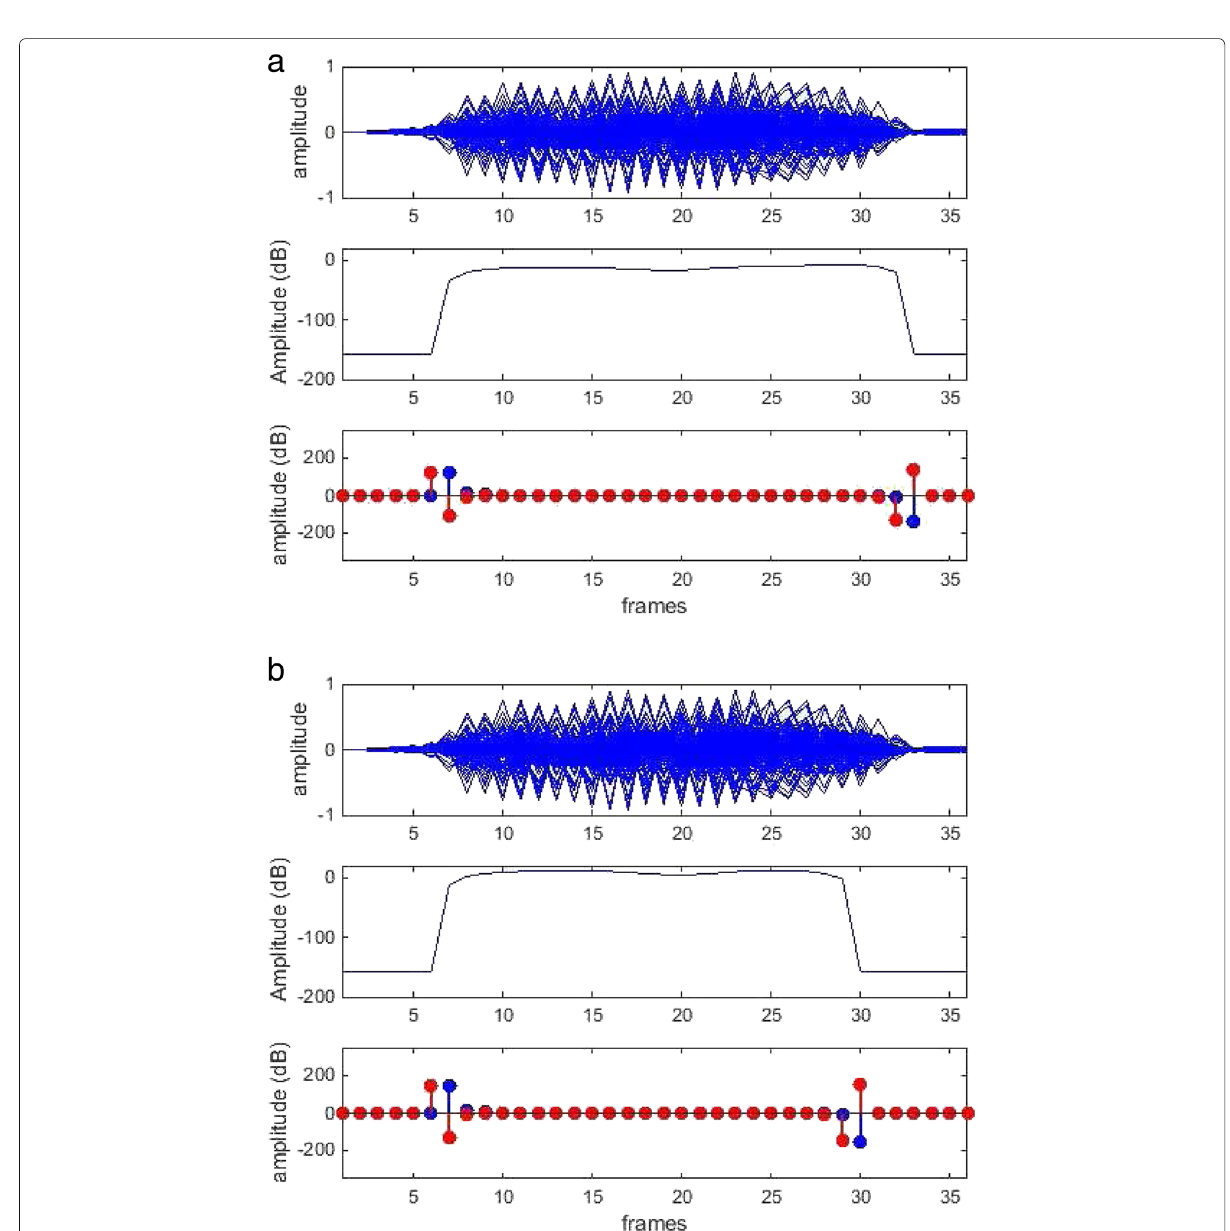
Fig. 3 Subband observations of utterance /ha/, log power spectra, and their first and second derivatives. Blue and red lines represent first and second derivatives, respectively. a Subband at 250 Hz. b Subband at 875